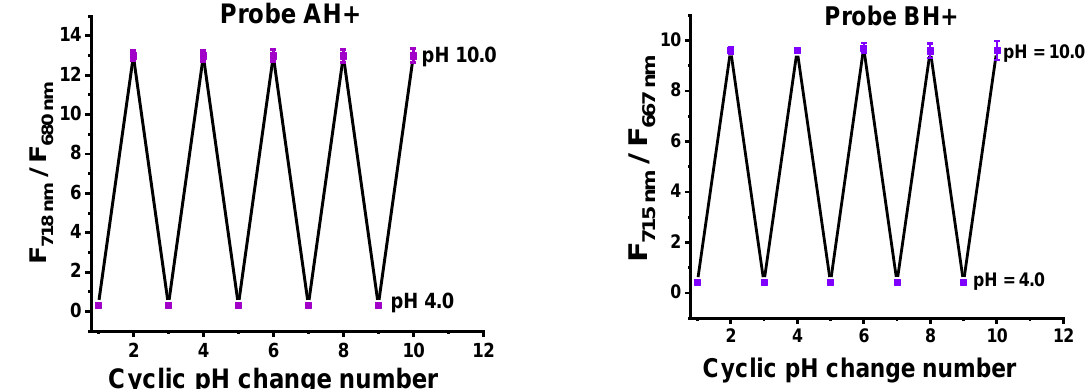
Figure 5. Fluorescence ratio changes of 10 µ M probes AH + ( left ) and BH + ( right ) versus cyclic pH changes from 4.0 to 10.0 or 10.0 to 4.0. Table 1. Photophysical data of the probes.